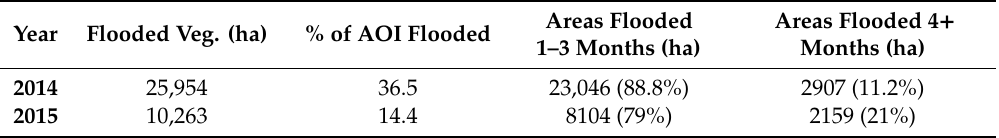
Table 6. Comparison of flooded vegetation area and duration in months for 2014 and